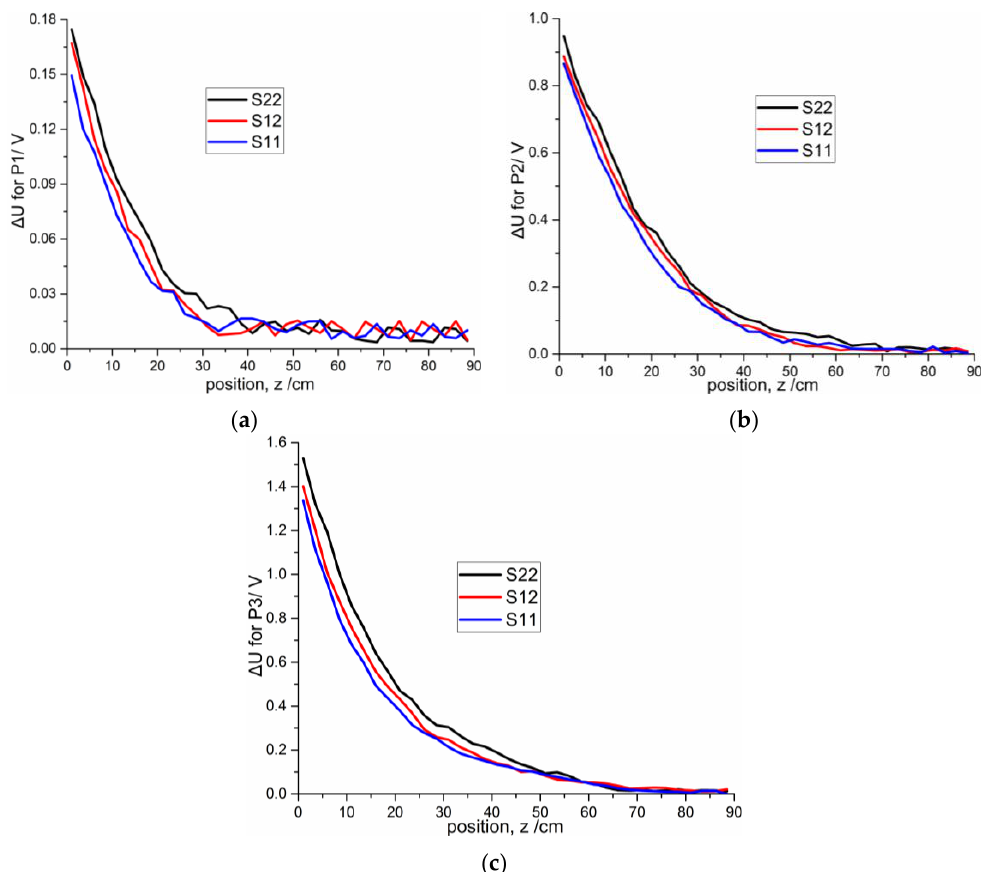
S , S and S for three projectiles with 11 12 22